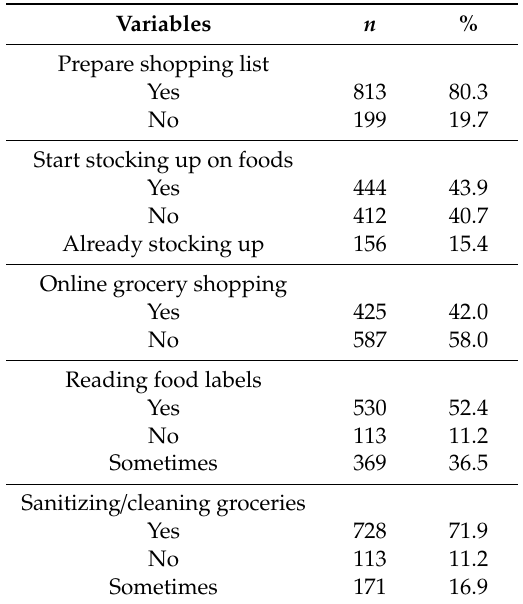
Table 6. Shopping practices during COVID-19 pandemic ( n = 1012). Variables